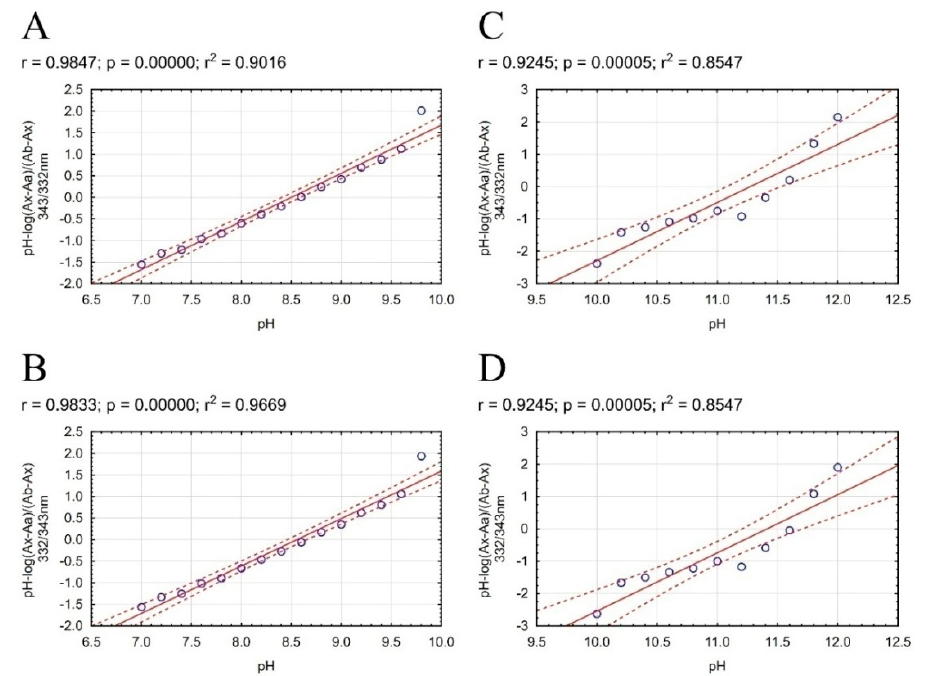
Figure 2. Scatterplots of mathematical formula results obtained for 3e compound with regression equation. The regression line is marked on the continuous line. Dashed lines determine the area of regression belt at the confidence level 0.95. ( A ) plot pH vs pH-log(A x − A a )/(A b − A x ) 332/343 nm; ( B ) plot pH vs. pH-log(A x − A a )/(A b − A x ) 343/332 nm; ( C ) plot pH vs. pH-log(A x − A a )/(A b − A x ) 332/343 nm; ( D ) plot pH vs. pH-log(A x − A a )/(A b − A x ) 343/332 nm.